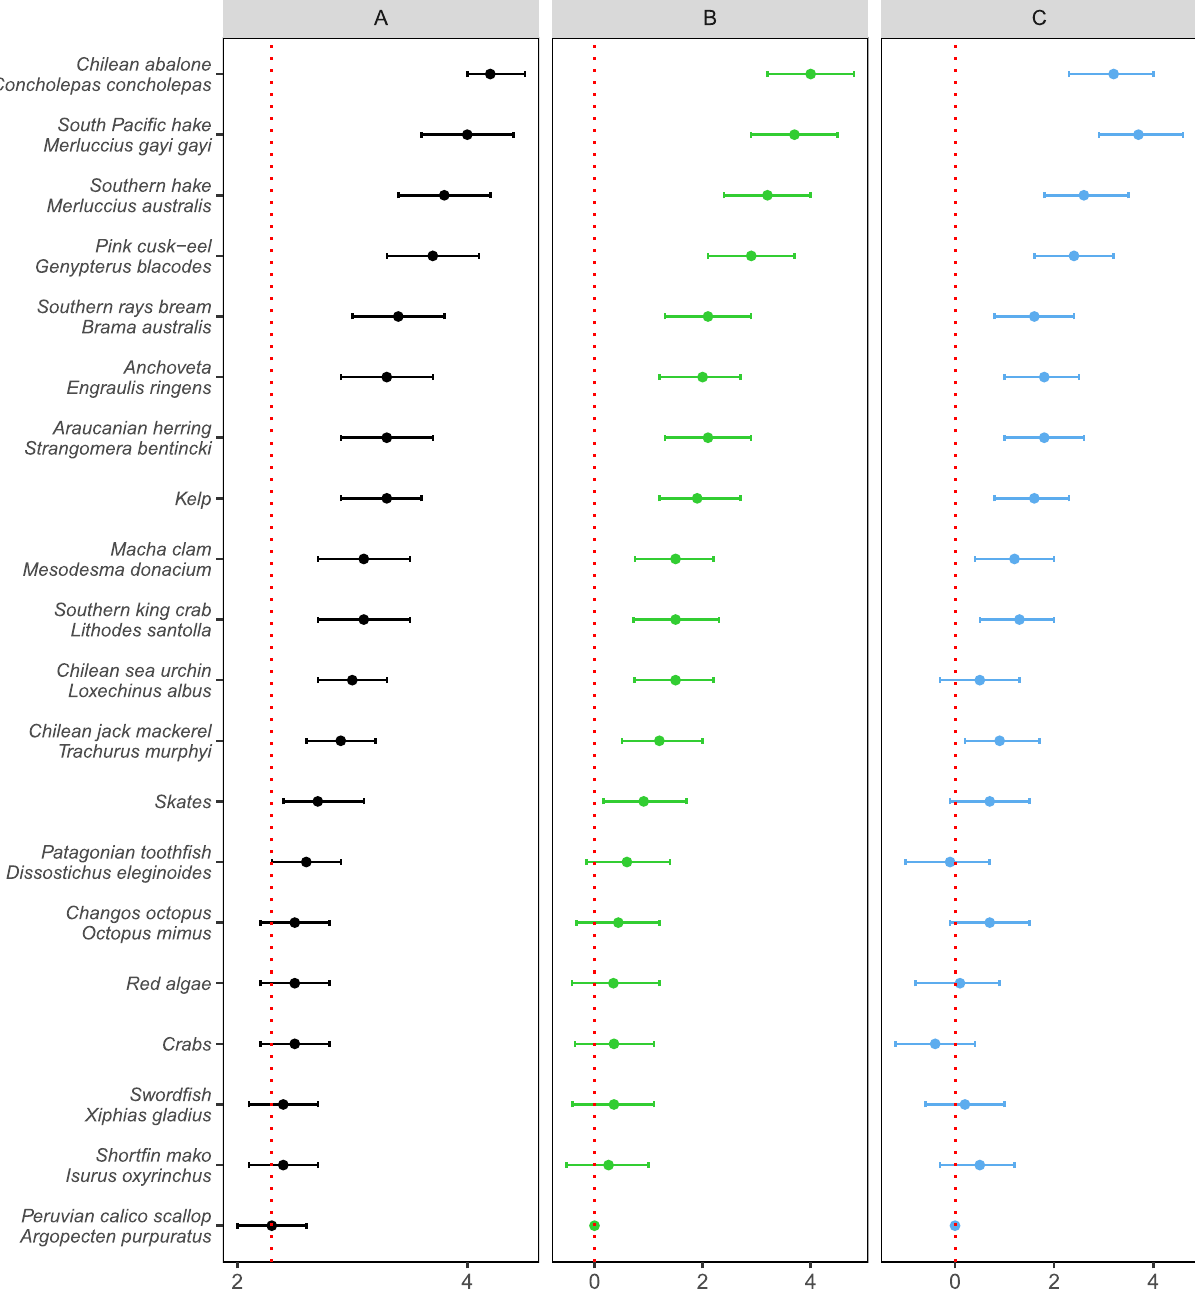
Figure 1. Illegal fishing estimates for 20 Chilean fisheries. ( A ) Mean raw scores (nominal, 1–5) as reported by fishery enforcement officers. ( B ) Predicted estimates from a mixed model with respondent as a random factor. ( C ) Predicted estimates from a mixed model with respondent as a random factor, while also controlling for self- reported experience for each fishery. For ( B ) and ( C ), Peruvian calico scallop is the reference fishery, which also has the lowest mean raw IUU score. Error bars are 95% confidence